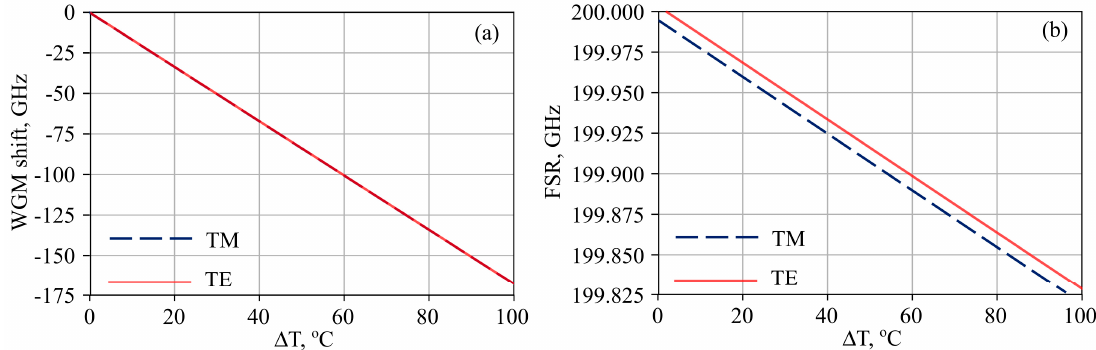
Figure 5. WGM shift ( a ) and free spectral range (FSR) ( b ) as functions of temperature increase for a microsphere with a diameter of ~328.5 μ m.